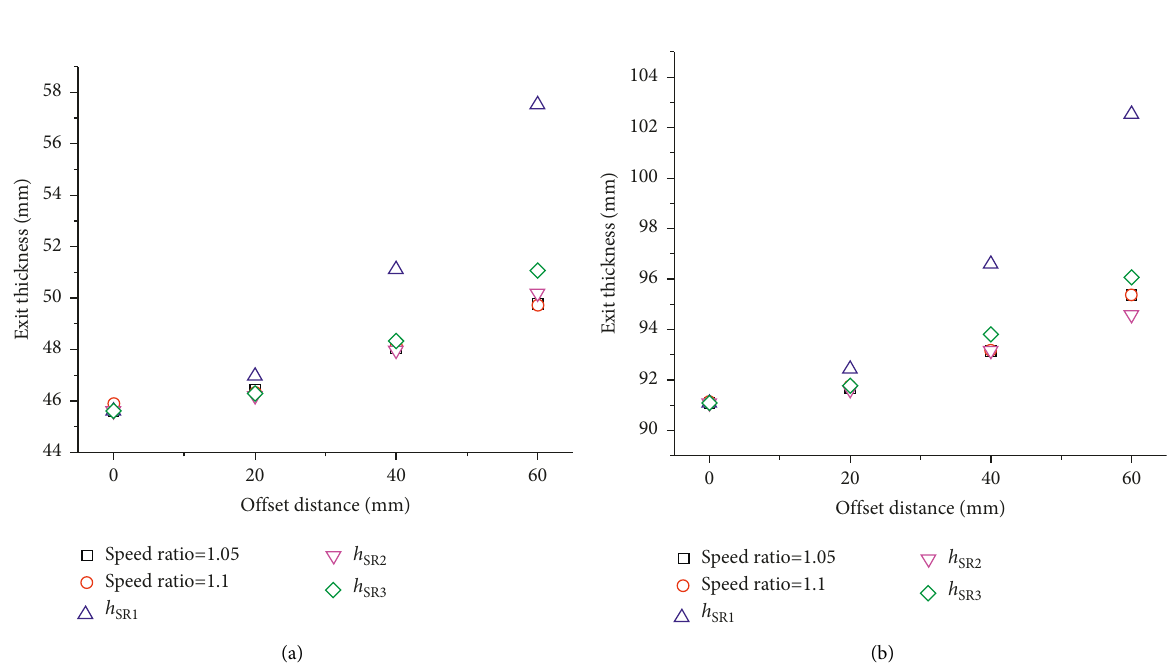
Figure 5: Exit thickness calculated by different formulas and simulation after snake rolling with the initial thickness being (a) 50mm and (b) 100mm.